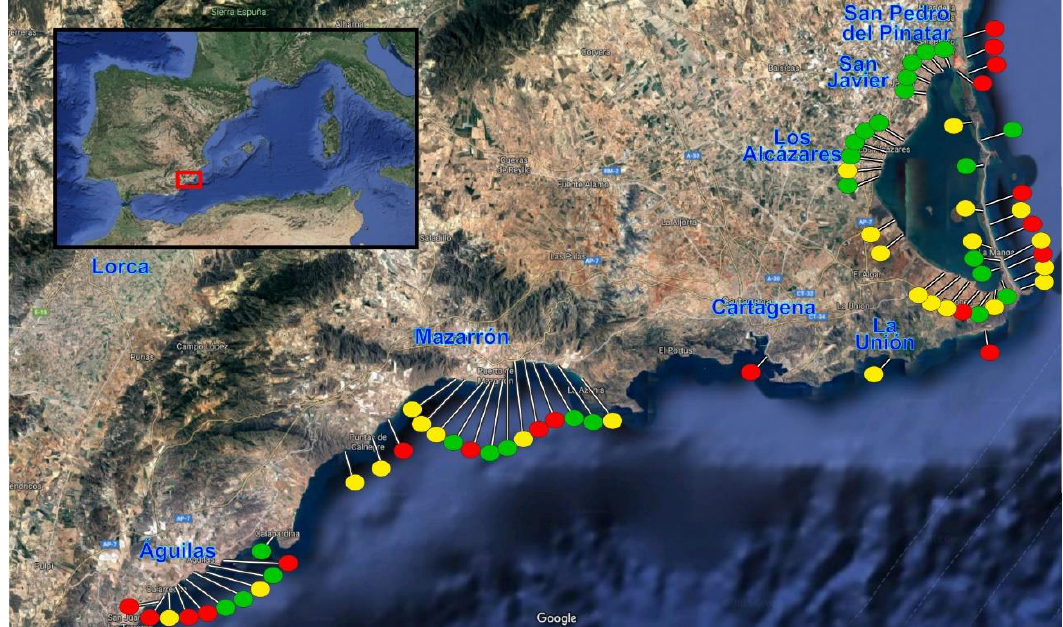
Figure 2. Geographical location of the beaches analyzed in the field study. The color of the circle indicates the resulting accessibility level: red (low, levels 0, 1, and 2); yellow (intermediate, levels 3 to 7); green (high, levels 8 and 9). Aerial views extracted from Google Maps.